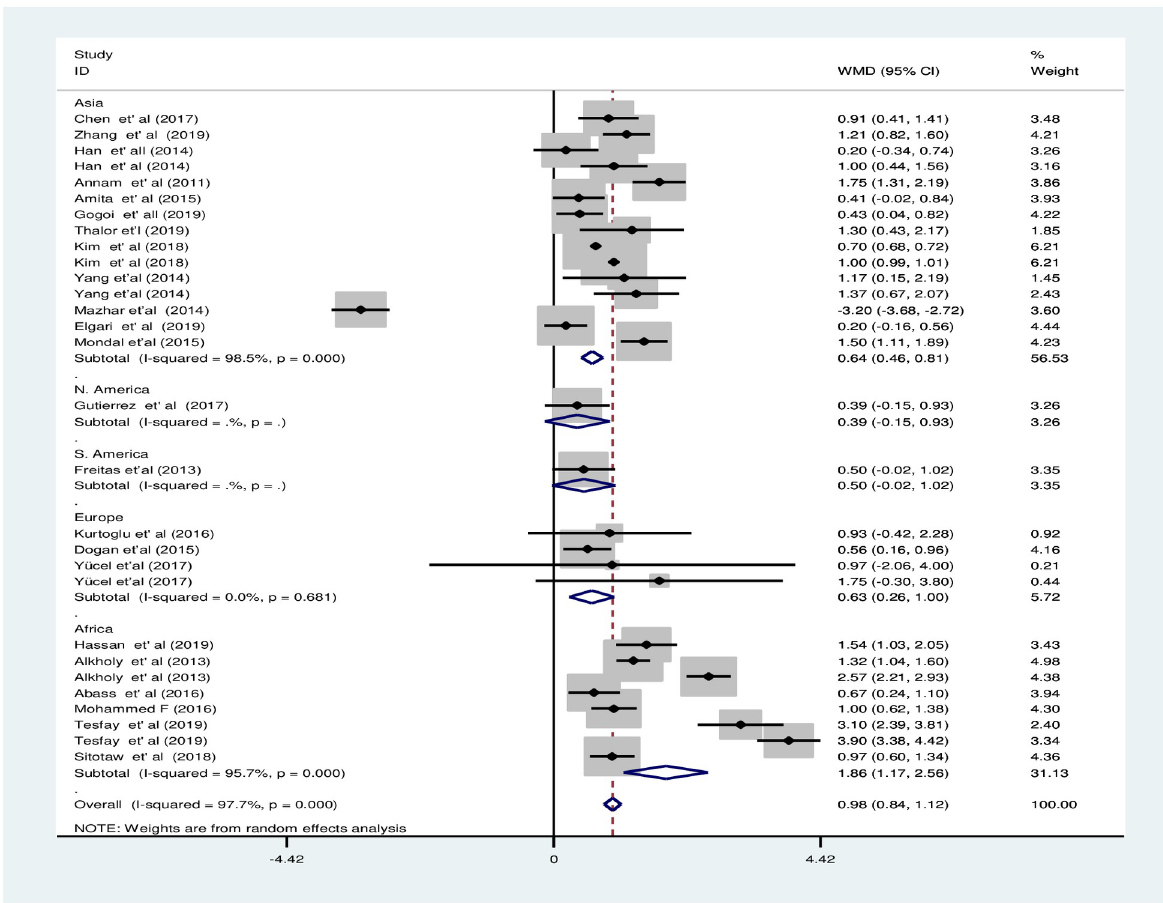
Fig 11. Forest plot of subgroup analysis for the pooled WMD estimate of MPV by study design using random effect model.